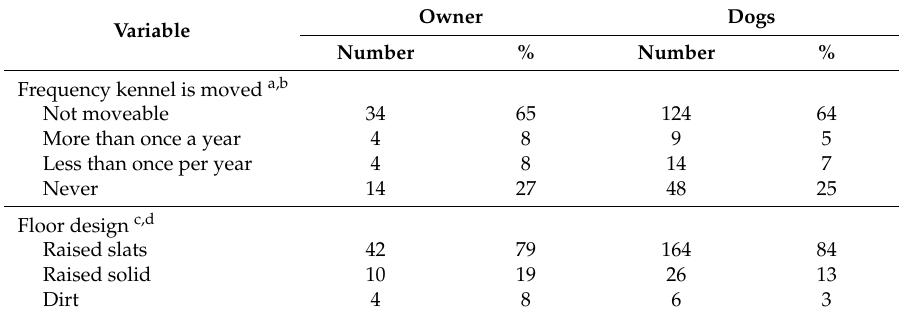
Table 2. Characteristics of housing for owners and working dogs from 53 owners and their 196 dogs. Data from a cross-sectional survey of 54 owners that completed a questionnaire about husbandry and management of their dogs.